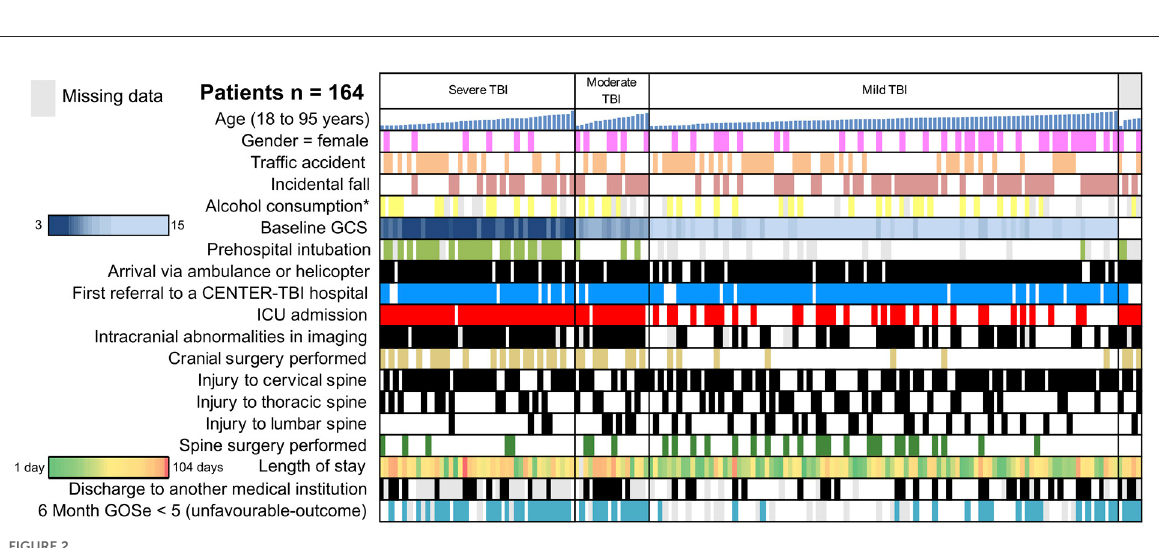
one-third of the patients achieved a full recovery (GOSe 7 or 8). To compare the outcomes of TBI patients with and without isolated, concomitant TSI, we performed propensity score matching with subsequent weighted logistic regression to estimate the effect of the simultaneous spine injury on patient outcomes. Patients were matched with age, sex, baseline GCS, performed cranial surgery, intracranial CT abnormalities, and